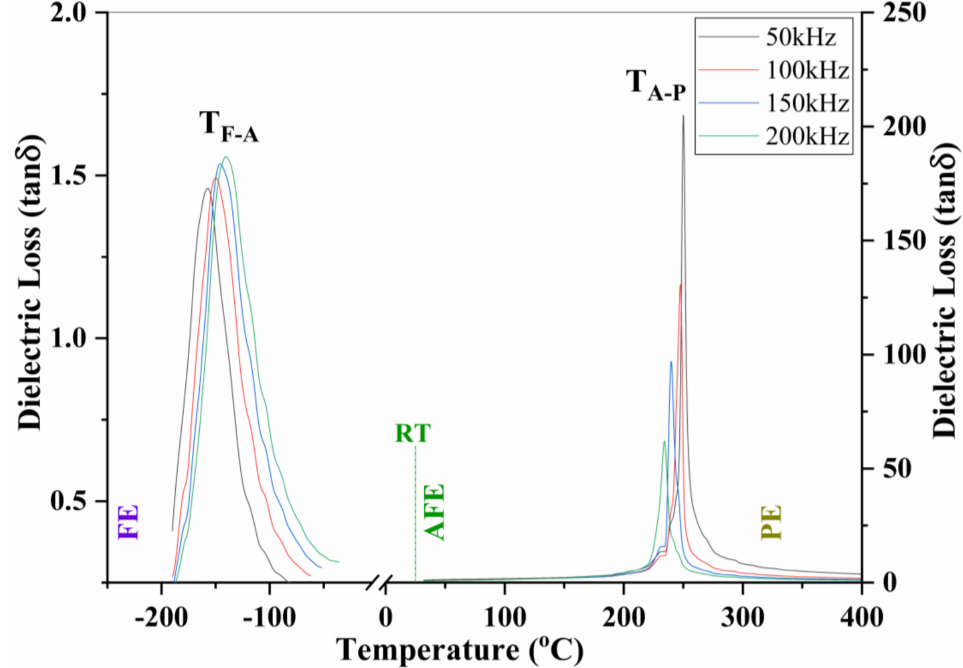
Figure 3. The temperature-dependent dielectric loss spectrum of La 0.5 Sr 0.5 Fe 12 O 19 ceramics as a function of frequency within the range of − 200 ◦ C to 400 ◦ C, and the frequency spans from 50 kHz to 200 kHz. RT represents room